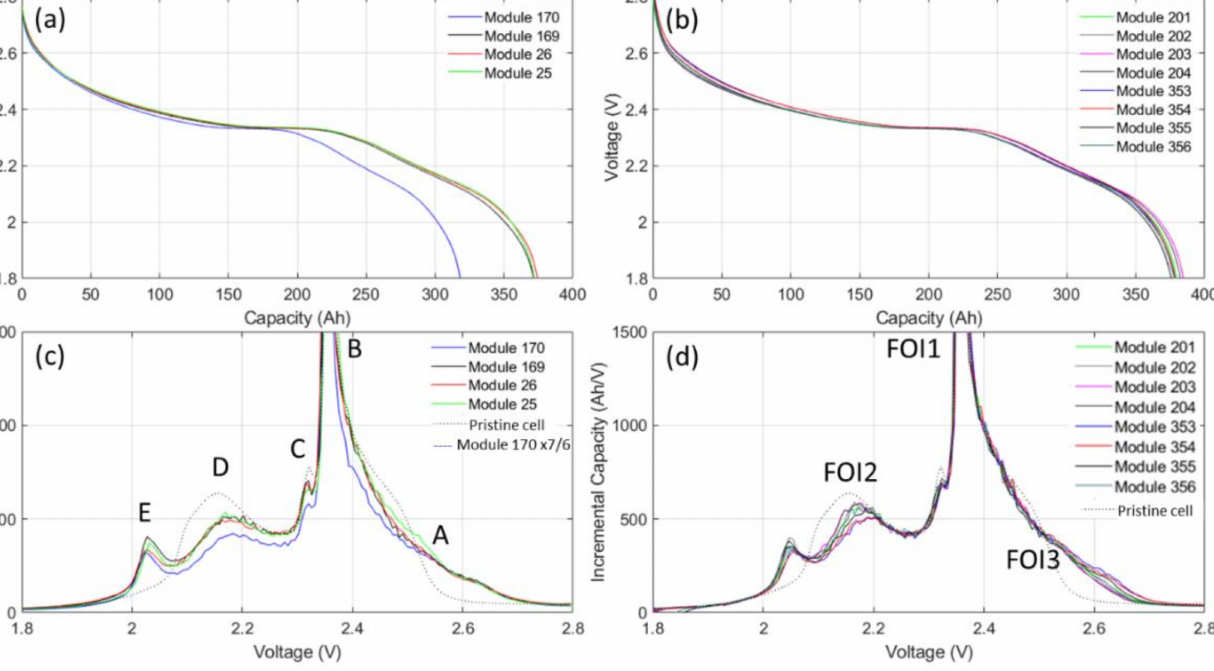
Figure 9. ( a , b ) C/25 discharges and ( c , d ) corresponding C/25 charge and discharge IC signature of replaced modules after day 1000 ( a , c ) and 2500 ( b , d